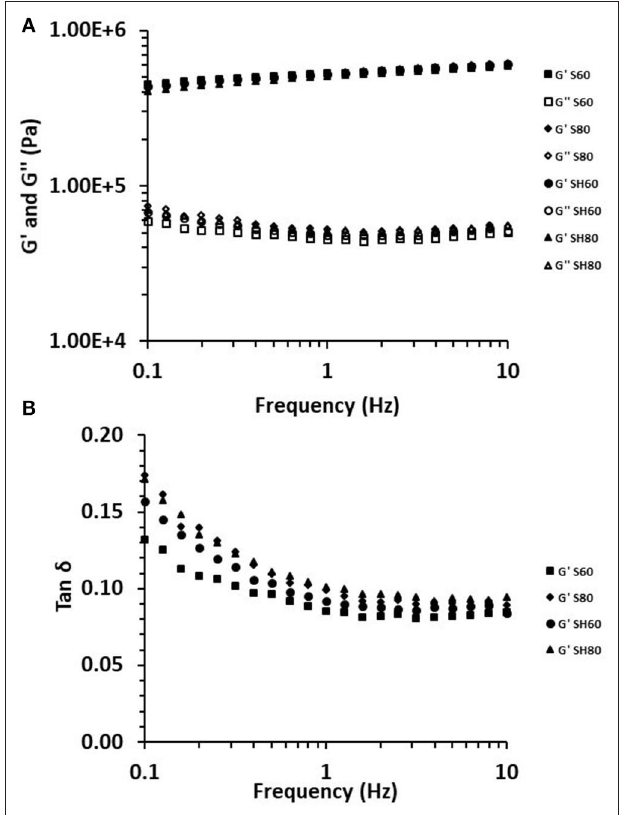
FIGURE 3 | Frequency sweep (A) , and tan δ as a function of frequency (B) for oleogels prepared with sunflower (S) and high oleic sunflower oil (SH), and developed by conventional drying at 60 ◦ C (S60, SH60) and 80 ◦ C (S80, SH80).